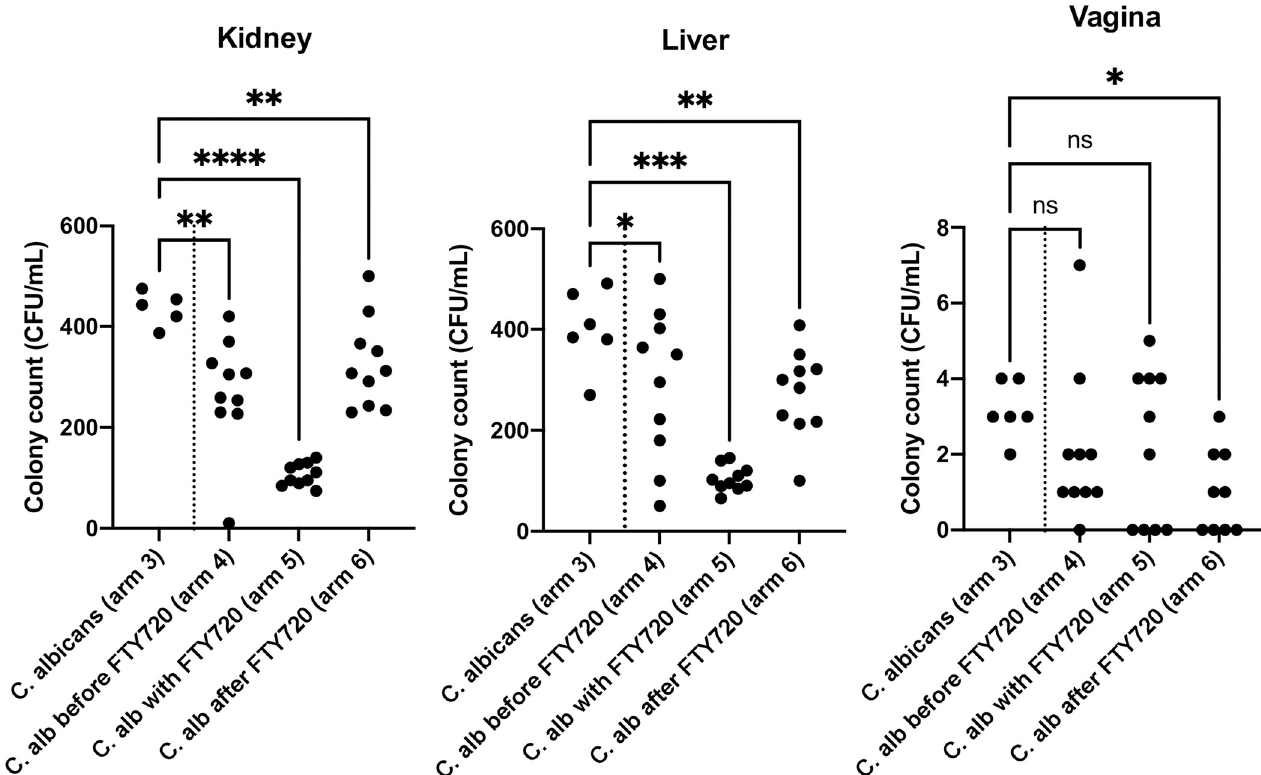
Fig 7. Colony counts of C . albicans in kidneys, livers, and vaginas of the mice inoculated with C . albicans at the end of the in vivo study, i.e., after 21 days of oral intervention. ns: p > 0.05; � 0.01 < p < 0.05; �� 0.001 < p < 0.01; ��� 0.0001 < p < 0.001; ���� p < 0.0001. Abbreviations: C. alb, Candida albicans .